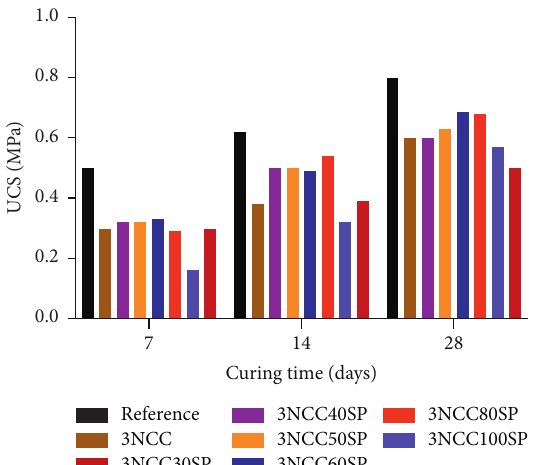
Figure 4: Mean unconfined compressive strength (UCS) for triplicate backfill samples prepared with 3% nano-calcium carbonate (NCC) and 0–100% superplasticizer (SP). See Table 5, for mixture designs.